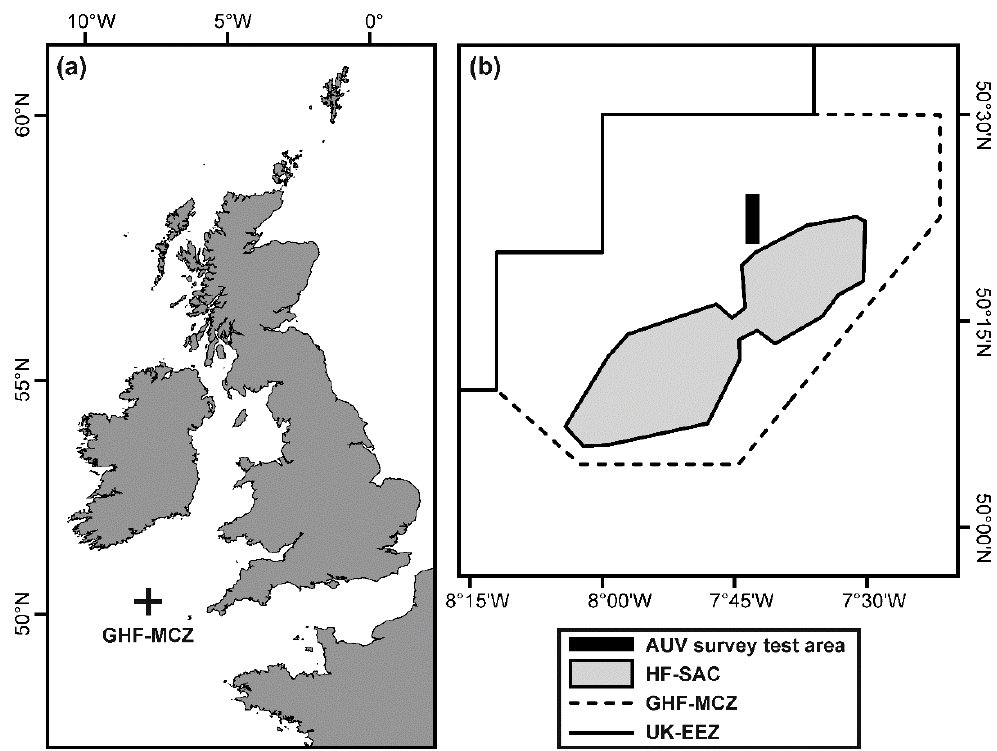
Figure 1. ( a ) General location of study area ( + ) in the Celtic Sea. ( b ) Boundaries of the Greater Haig Fras Marine Conservation Zone (GHF-MCZ), partly defined by the United Kingdom exclusive economic zone (UK-EEZ), the Haig Fras Special Area of Conservation (HF-SAC), and the autonomous underwater vehicle (AUV) survey test area.